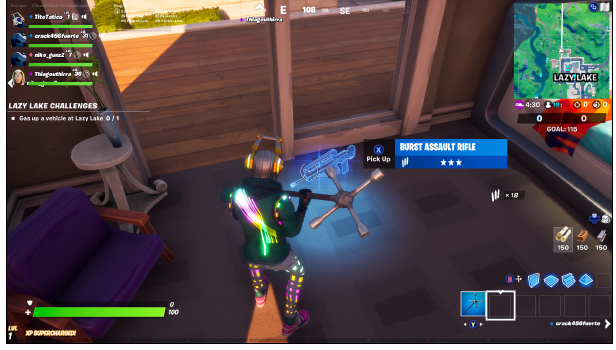
Figure 4. HUD showed in Fortnite (Epic